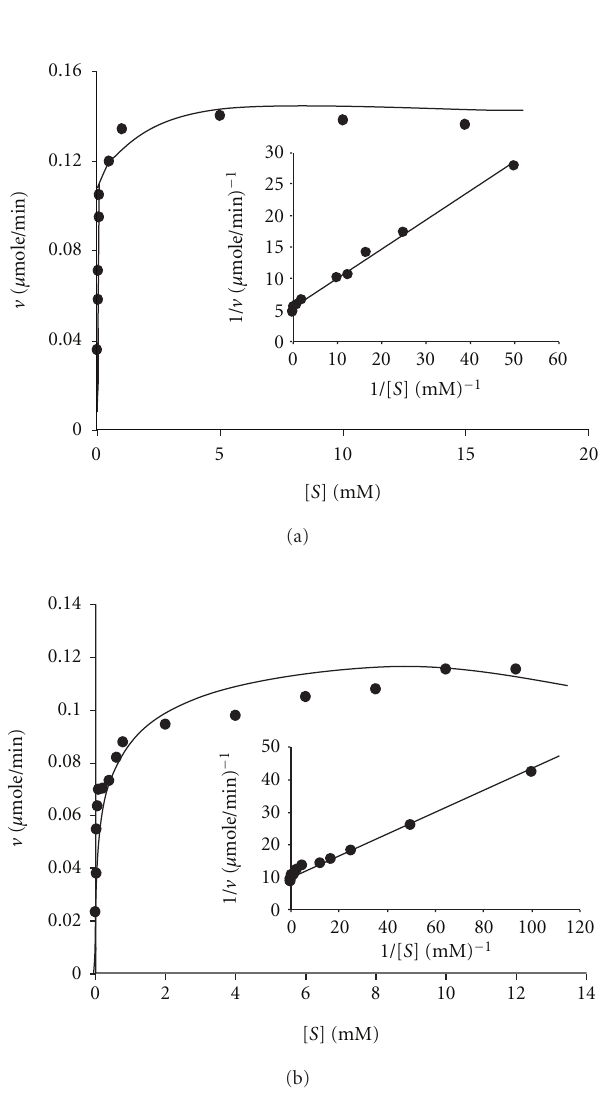
Figure 2: Michaelis-Menten and double reciprocal plots using (a) MnSO 4 and H 2 O 2 as the variable substrates, respectively. The reaction one mL contained “5 μ g of the enzyme (specific activity 4IU/mg) in 50 mM lactic acid-sodium lactate bu ff er pH 4.5 at 30 ◦ C”. In (a) H 2 O 2 was fixed at 100 μ M and in (b) MnSO 4 was fixed at 100 μ M for purified Mn peroxidase using MnSO 4 as the variable substrate at the fixed 50 μ M concentration of H 2 O 2 . Details given in Section